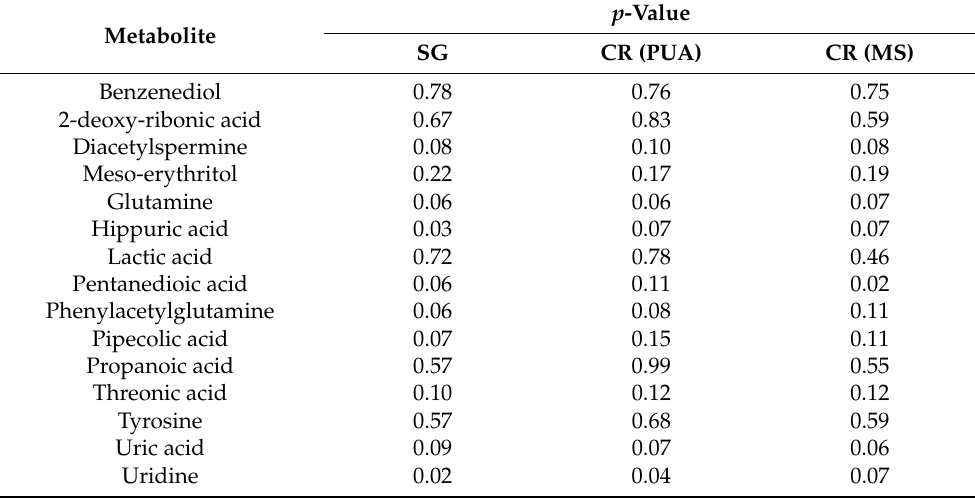
Table 1. A summary of the significance of differences in metabolite levels (point 1 vs. point 3) and resulting from applied normalization strategy. Signal intensities were normalized by specific gravity or creatinine level; SG—specific gravity; CR (PUA)—creatinine level measured with the use of portable urine analyzer; CR (MS)—creatinine signal measured with the use of